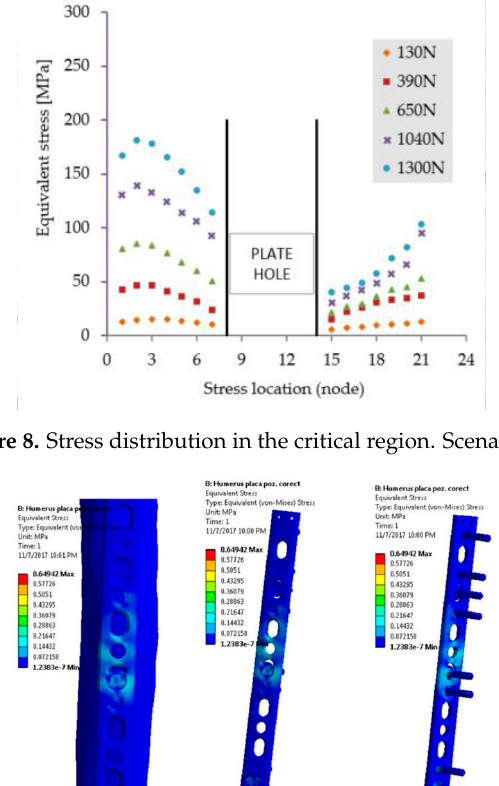
Figure 8. Stress distribution in the critical region. Scenario II.